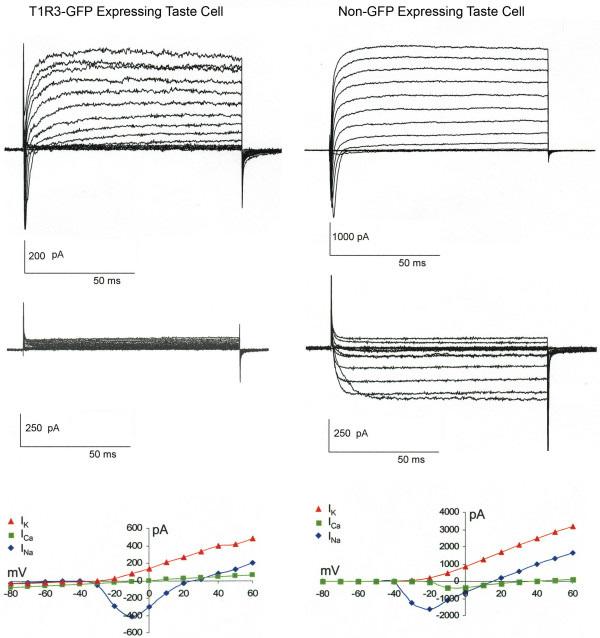
Whole cell voltage clamp recordings from a T1R3-GFP expressing taste cell (left panel) and a non-GFP-expressing taste cell (right panel). Holding potential was -80 mV, and the membrane was stepped from -80 to +60 mV to elicit voltage-gated currents. Top panels show recordings in Tyrode's, while middle panels show recordings in Ba2+ Tyrode's to reveal Ba2+ currents through voltage gated Ca2+ channels. Bottom panels illustrate the current/voltage relationship.